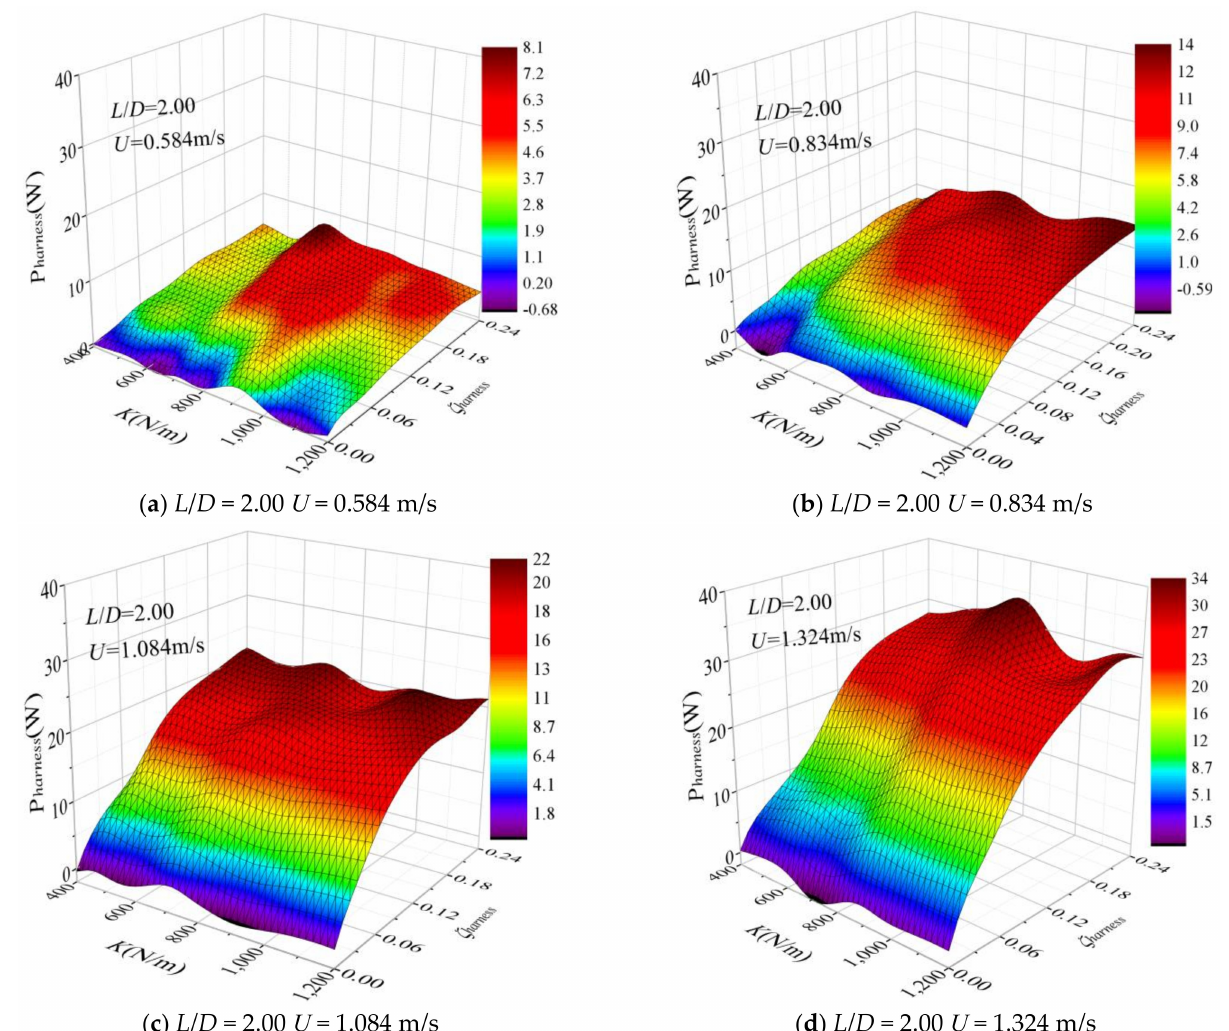
Figure 7. Power harvesting at various K and ζ harness based on BP modeling for tandem cylinders with L / D = 2.00: ( a ) U = 0.584 m/s; ( b ) U = 0.834 m/s; ( c ) U = 1.084 m/s; ( d ) U = 1.324